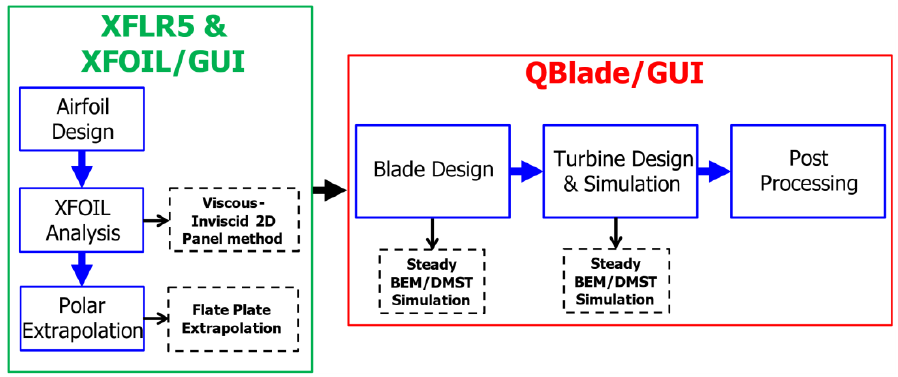
Figure 7. Software modules inside QBlade.